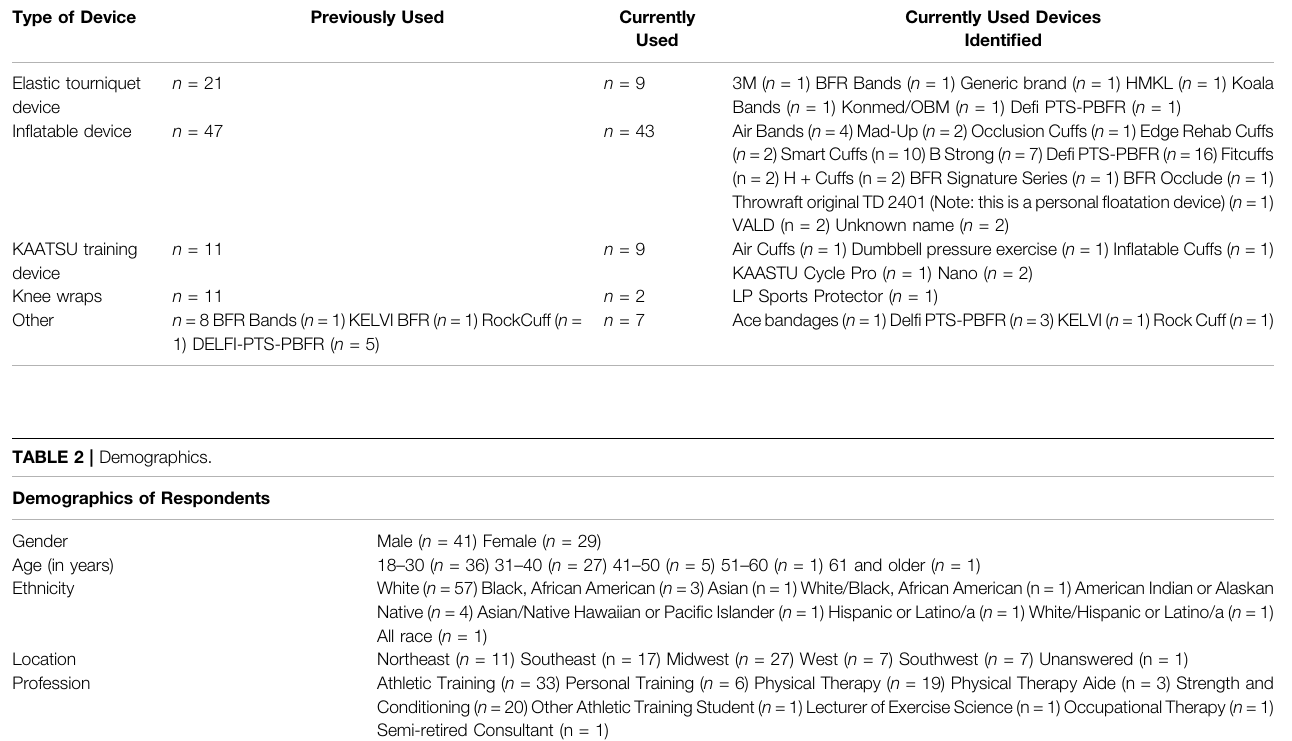
TABLE 1 | Previously and currently used devices as indicated by respondents.